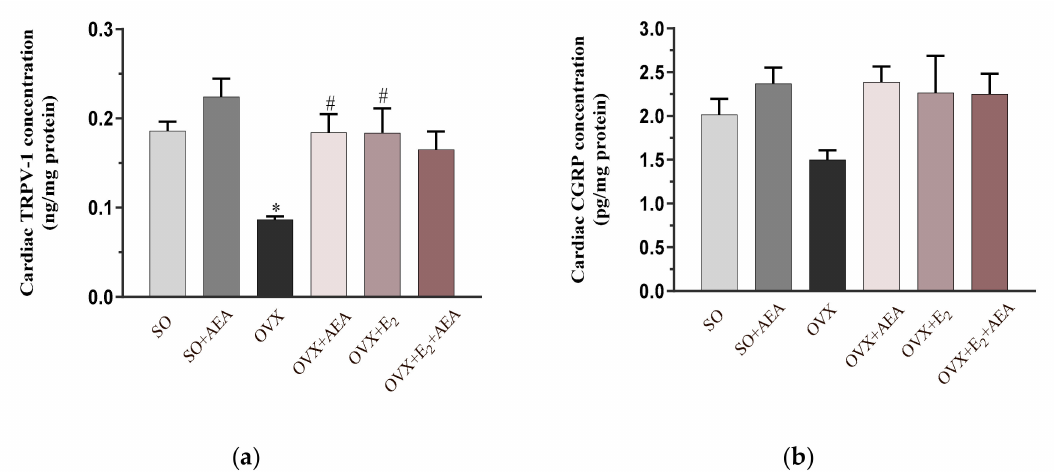
Figure 5. E ff ects of anandamide and estrogen treatment on cardiac TRPV1 and CGRP concentrations in SO and OVX animals. ( a ) Cardiac TRPV1 concentration (expressed as ng / mg protein); results are shown as means ± S.E.M. n = 5–9; ( b ) cardiac CGRP concentration (expressed pg / mg protein; results are shown as means ± S.E.M. n = 6–11; * p < 0.05: statistical significance relative to the SO group, # p < 0.05: statistical significance relative to the OVX group. TRPV1 = transient receptor potential vanilloid 1, CGRP = calcitonin gene related